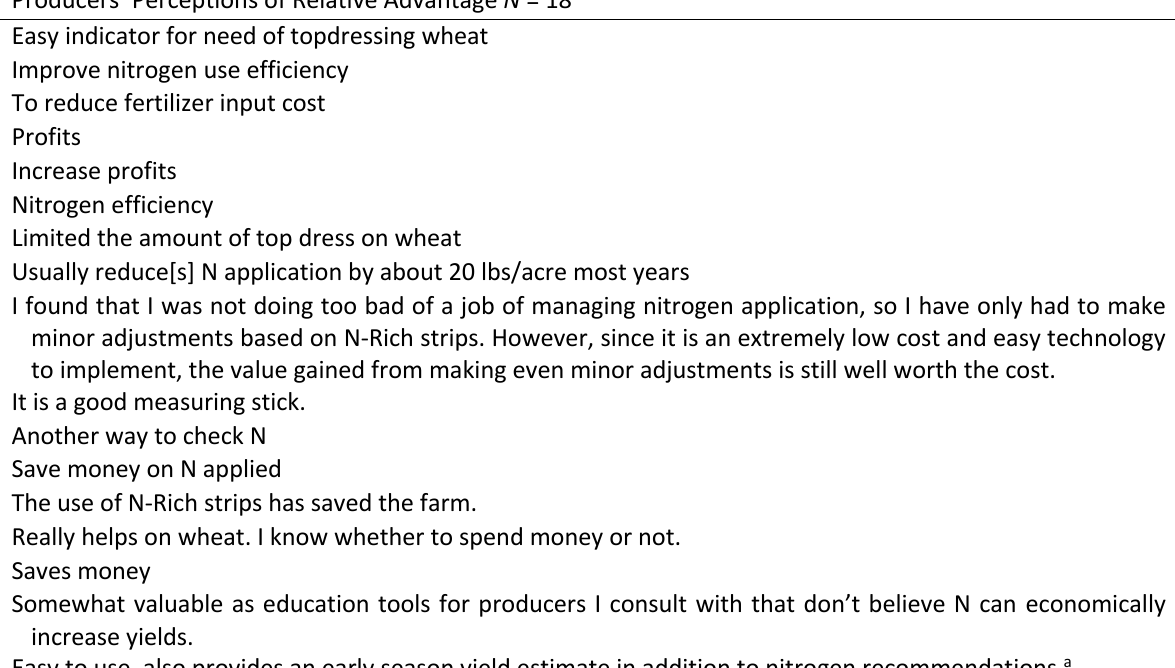
Producers’ Perceptions of Selected Attributes of PA Technologies as Written Responses Producers’ Perceptions of Relative Advantage N =